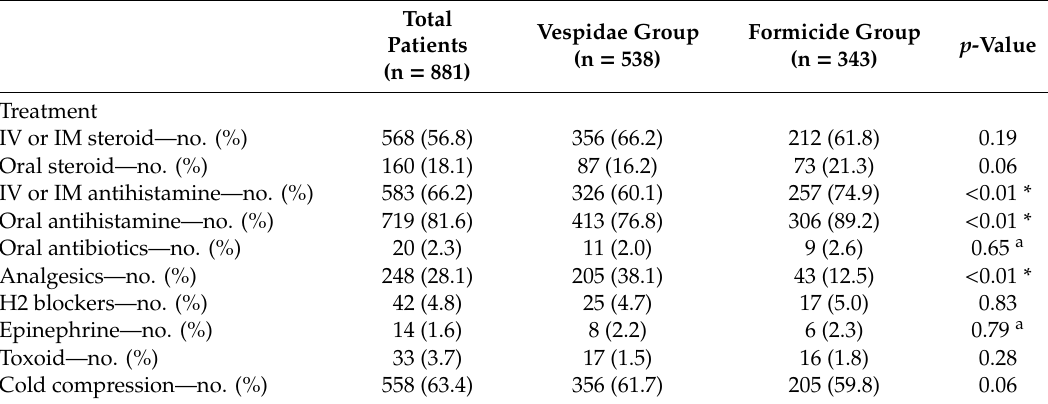
Table 2. Treatment for the two study groups.